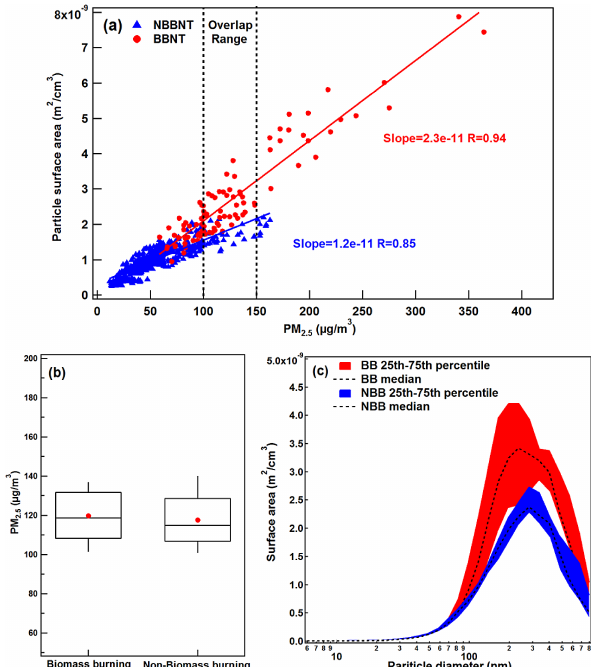
Figure 7. (a) Scatter plot between the particle surface area and PM 2 . 5 for nighttime samples during BB and non-BB periods, (b) whisker plot of PM 2 . 5 in the selected mass concentration range (100–150µgm − 3 , shown in Fig. 7a) during BB (51 samples) and non-BB periods (27 samples), and (c) particle surface area size dis- tributions for the same subsets of